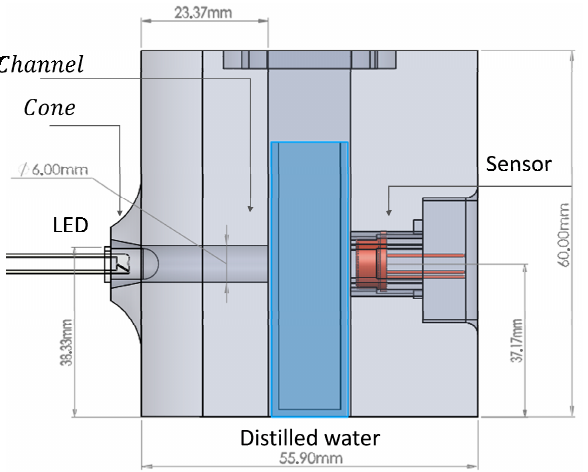
Figure 5. View of experiment assembly.